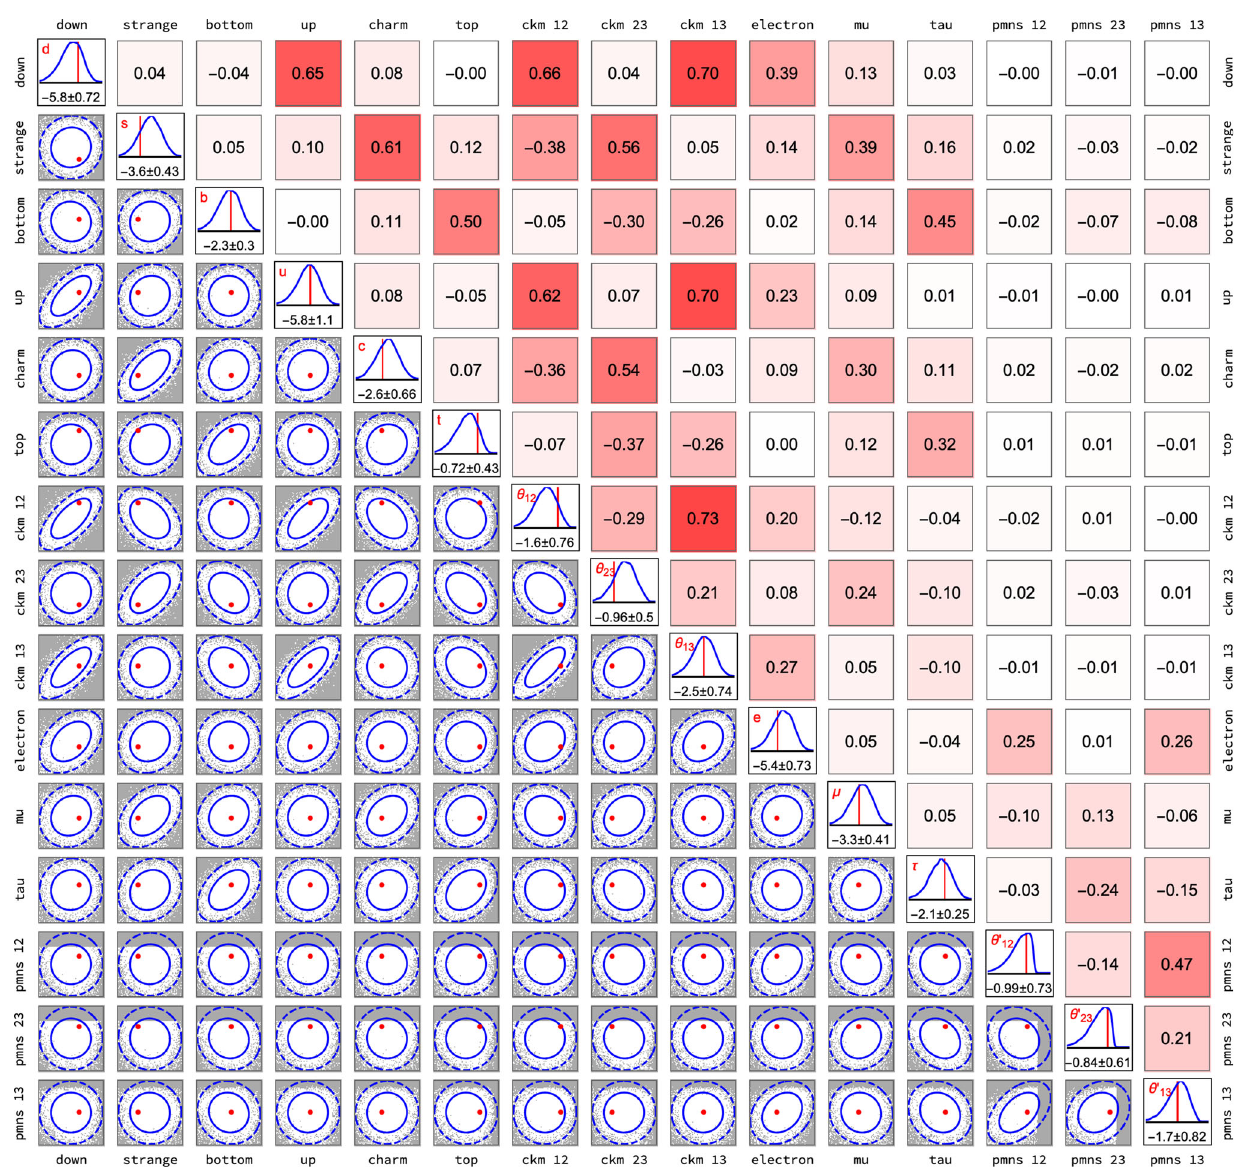
Fig. 2 The distribution of masses and mixings (parameters x i ) in the SU ( 5 ) model, for the case N = 1, N (cid:4) = 5 and tan β = 40. In the lower triangle,wedisplayscatterplotsofthetwo-dimensionalmarginaldistri- butions, with the solid (dashed) contour representing one (two) sigma, and the red dots the experimental value. In the diagonal, we show the